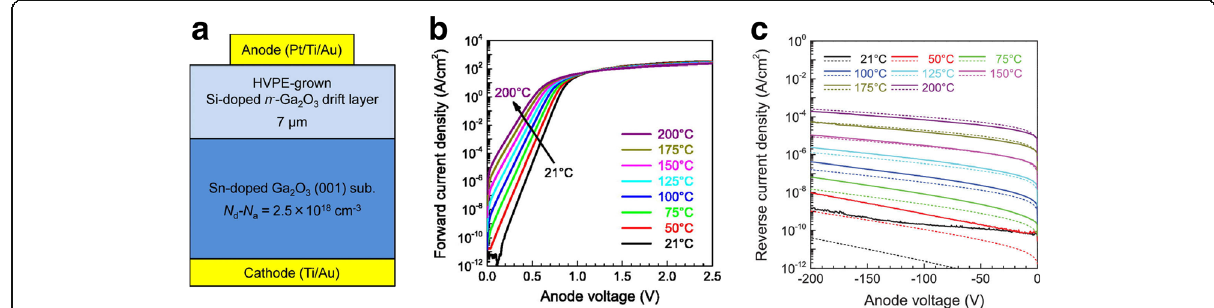
Fig. 7 a Structure of the SBD device based on the HVPE-grown 7- μ m-thick n − - Ga 2 O 3 homoepitaxial drift layer on n + - Ga 2 O 3 single crystal substrate. b Forward J – V characteristics of the device measured at 21 – 200 °C. c Reverse J – V at 21 – 200 °C (solid and dotted lines represent the experimental and simulated results, respectively). Reprinted from ref. [16]